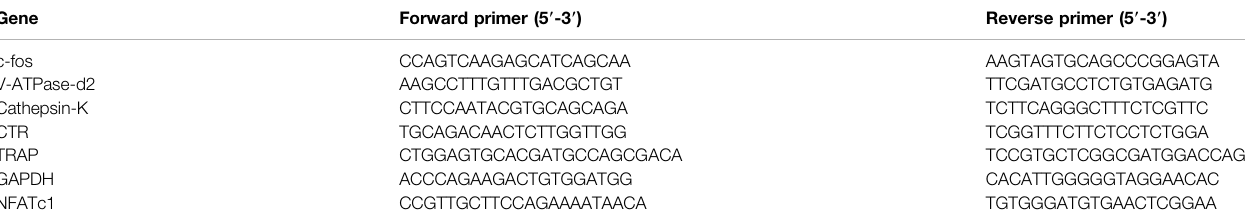
TABLE 1 | Quantitative polymerase chain reaction (q-PCR) analysis of mouse primer sequences.